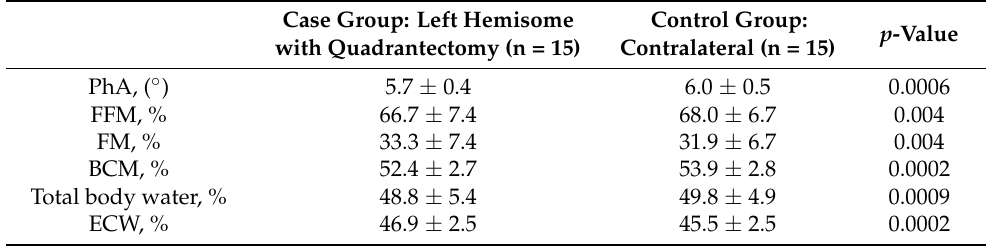
Table 4. Body composition of «side» left in patients with quadrantectomy vs. contralateral. Case Group: Left Hemisome Control Group: p -Value with Quadrantectomy (n = 15) Contralateral (n = 15) PhA, ( ◦ ) 5.7 ± 0.4 6.0 ± 0.5 0.0006 FFM, % 66.7 ± 7.4 68.0 ± 6.7 0.004 FM, % 33.3 ± 7.4 31.9 ± 6.7 0.004 BCM, % 52.4 ± 2.7 53.9 ± 2.8 0.0002 Total body water, % 48.8 ± 5.4 49.8 ± 4.9 0.0009 ECW, % 46.9 ± 2.5 45.5 ± 2.5